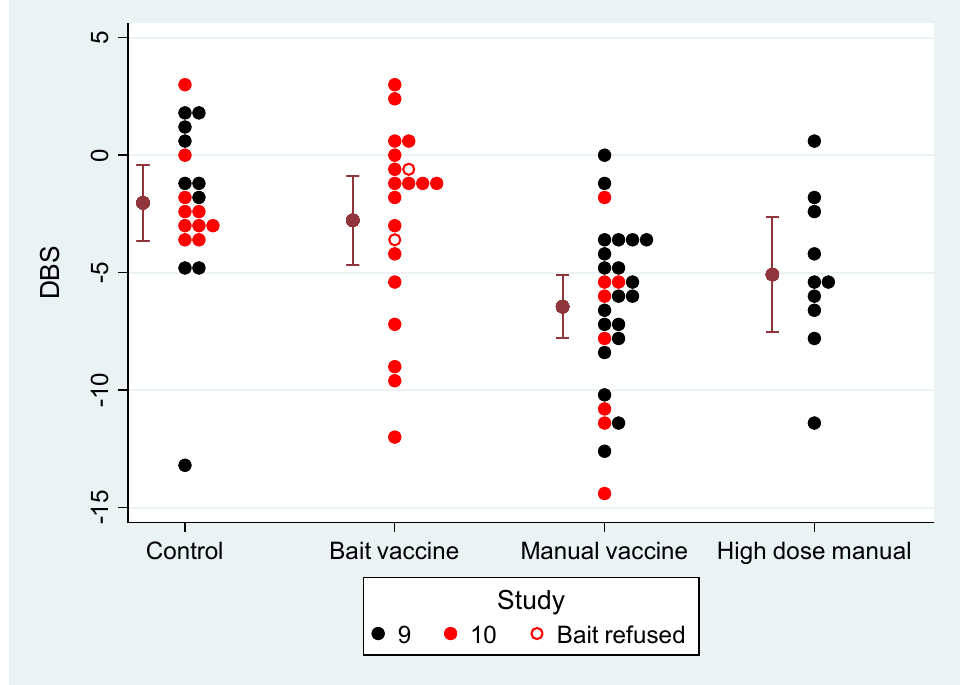
Figure 1. Disease Burden Score (DBS) plotted for each of the different treatments across VES9 (black dots) and VES10 (red dots). Controls were unvaccinated. The remaining badgers were either vaccinated by voluntary consumption of Bacillus of Calmette and Gu é rin (BCG) in bait (Bait vaccine, open dots refused bait) or by manual vaccination with 2.0 × 10 8 colony forming units (CFU) (VES9) or 8.4 × 10 8 CFU (VES10) BCG (plotted collectively as ‘Manual vaccine’) or with a higher dose (1.2 × 10 9 CFU) of BCG in VES9 only (plotted as ‘High dose manual’). Bars indicate mean with its 95% confidence interval.